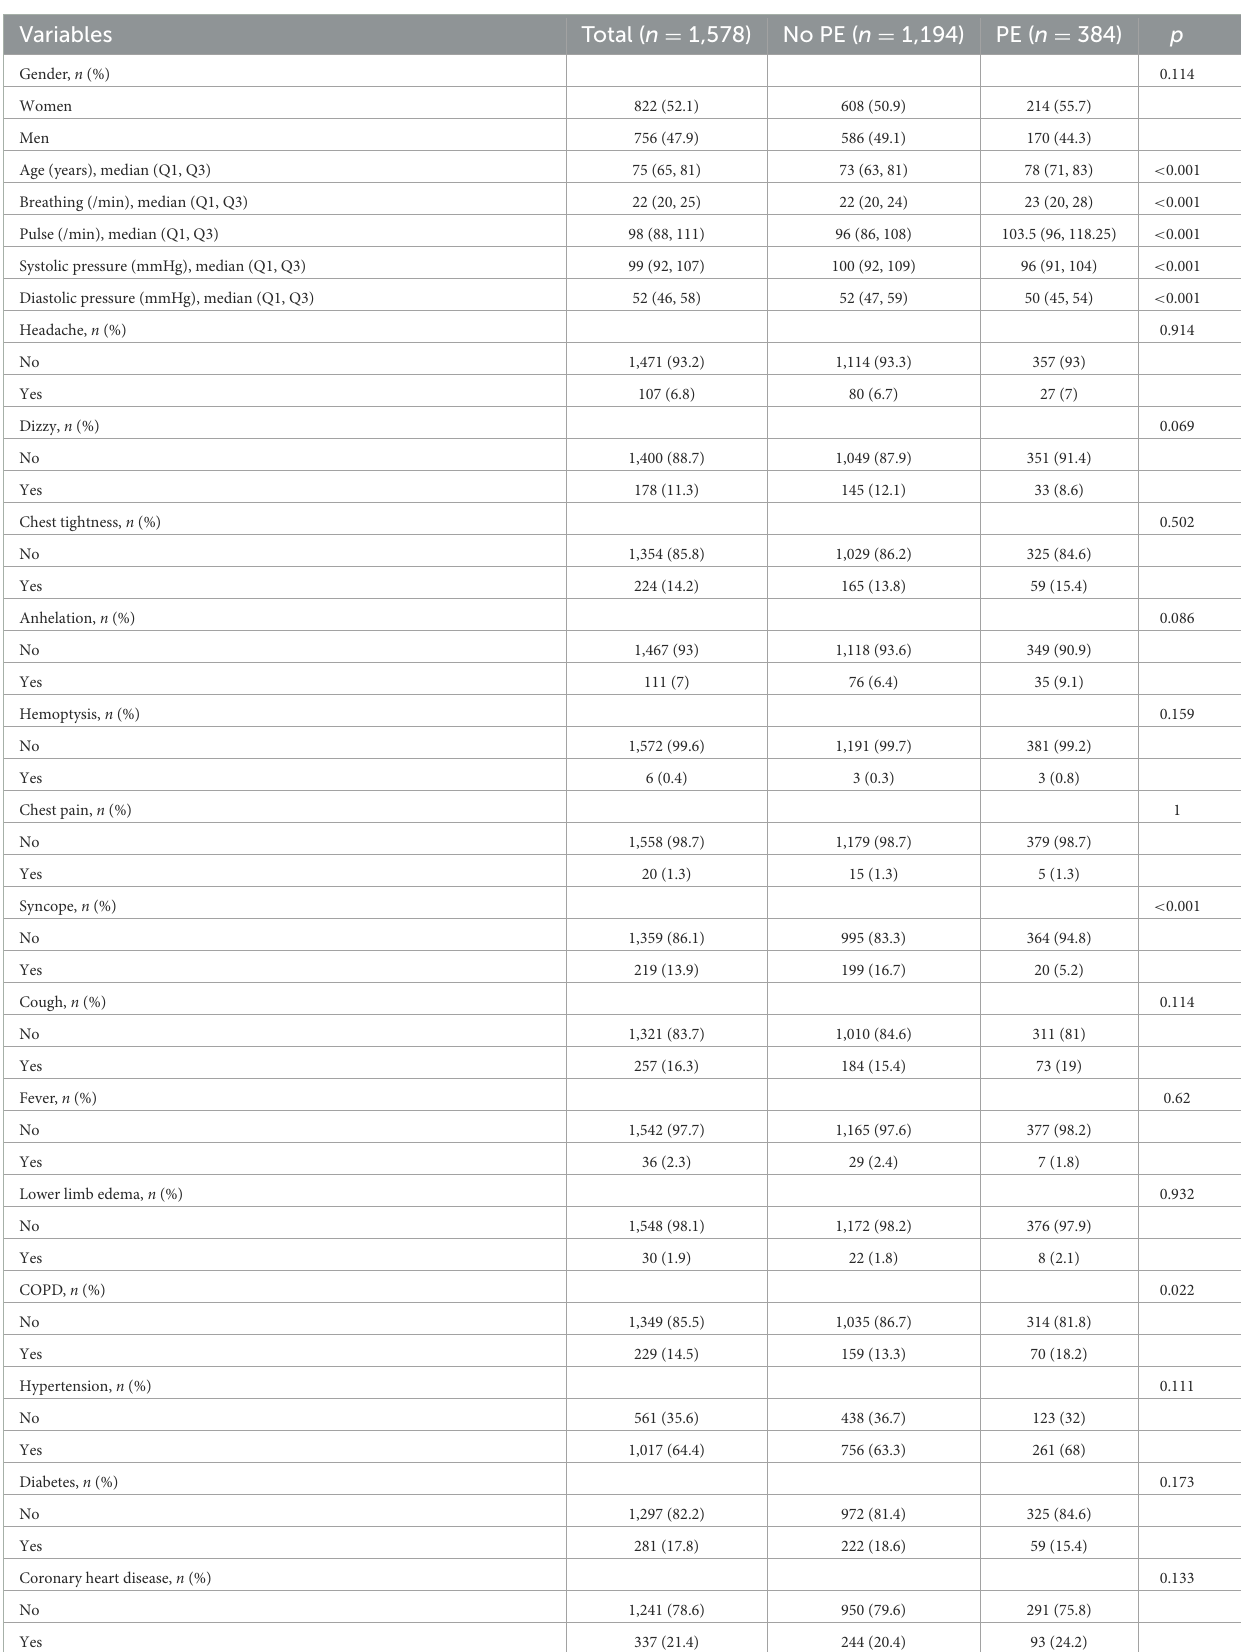
TABLE 1 Baseline characteristics of